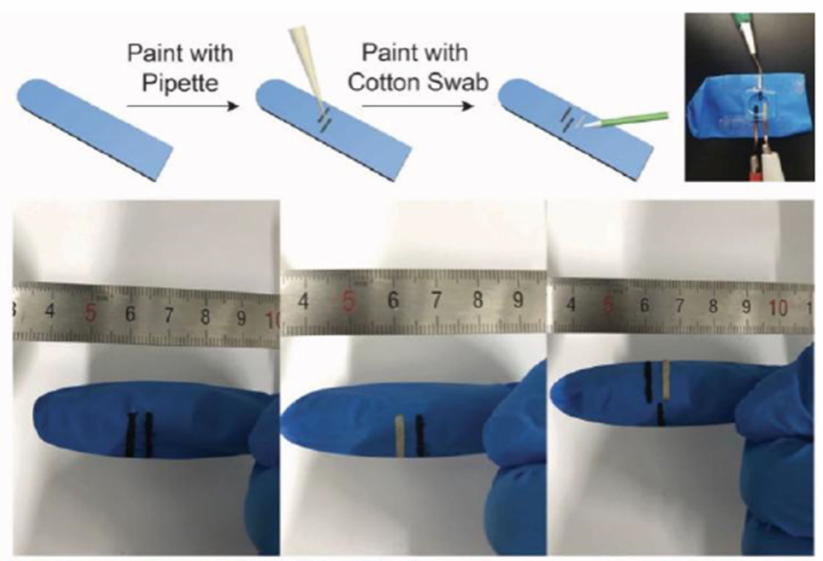
Figure 7. Camera images showing the process of fabrication of CNT-based biosensor-painted gloves (reprinted from Ref. no. [96], copyright 2018,